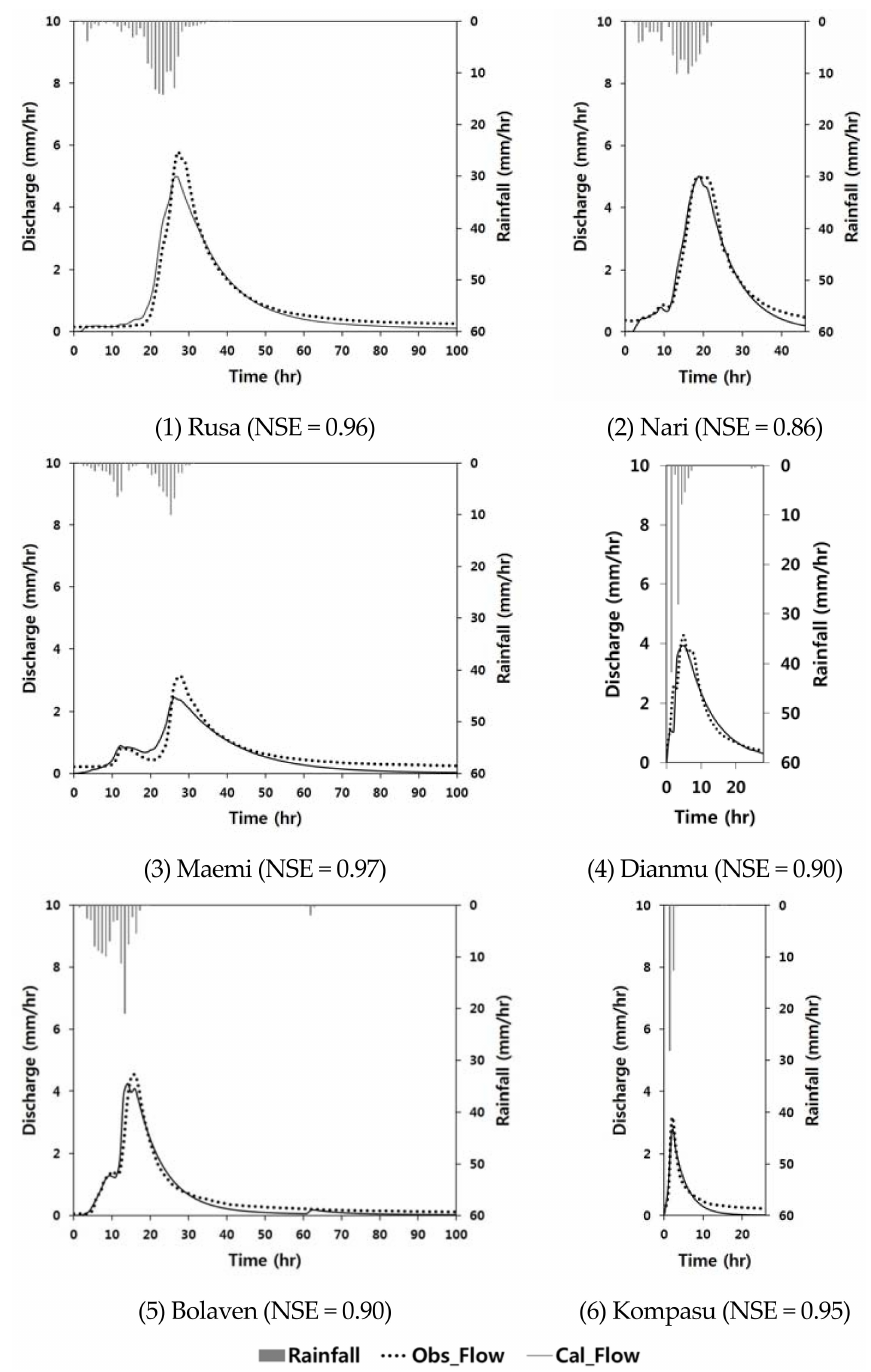
Figure 6. Observed and calibrated hydrographs for the six events at